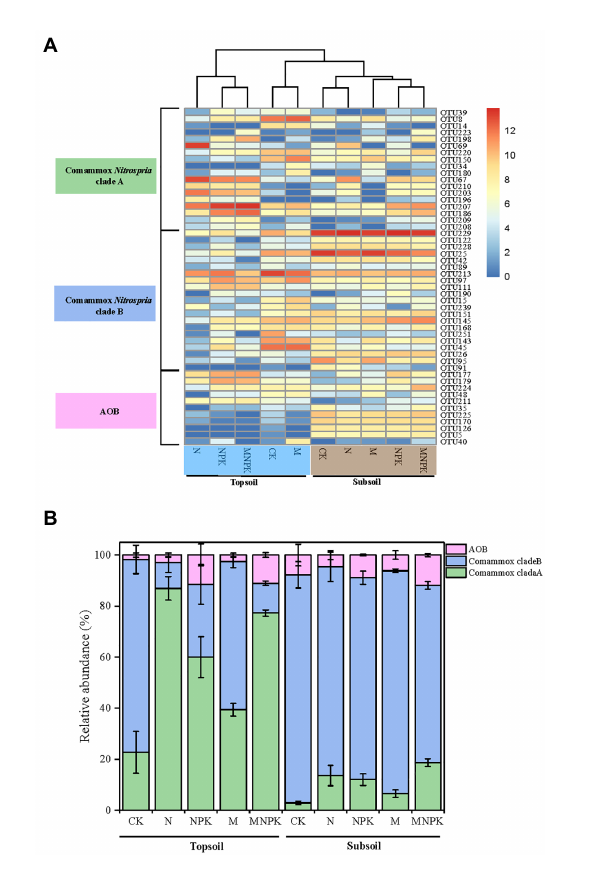
FIGURE 5 Heatmap plotting the relative abundance of the 50 major OTUs (relative abundance > 0.05 in at least one sample) (A) and community composition of comammox Nitrospira based on amoA gene sequences (B) retrieved for the 30 soil samples. Error bars are standard error of means ( n =